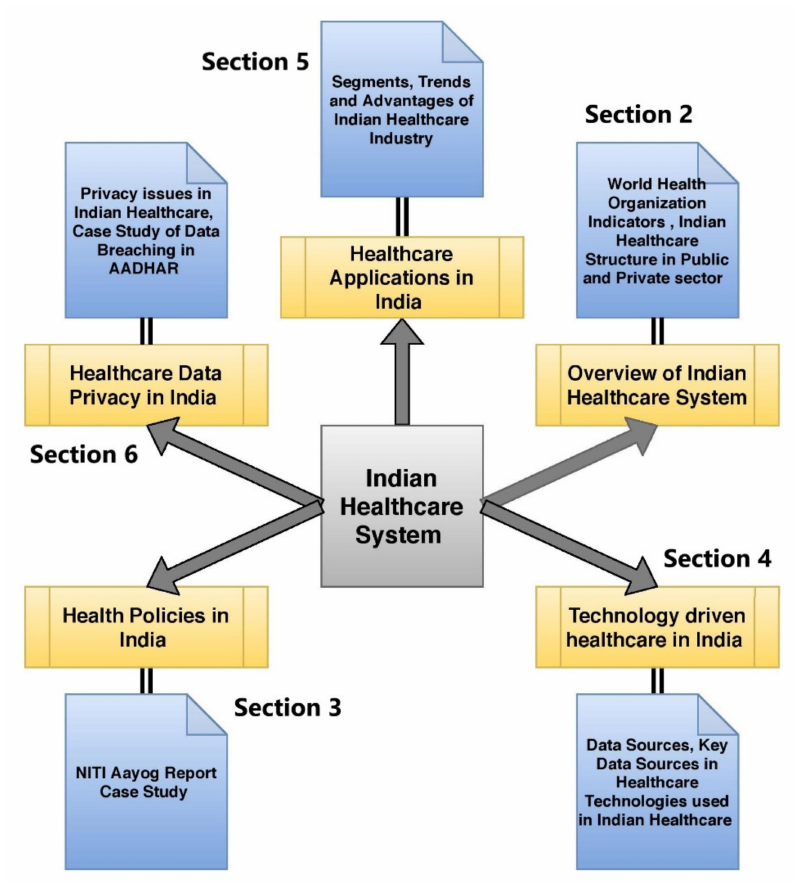
Figure 3. Structure and contribution of the